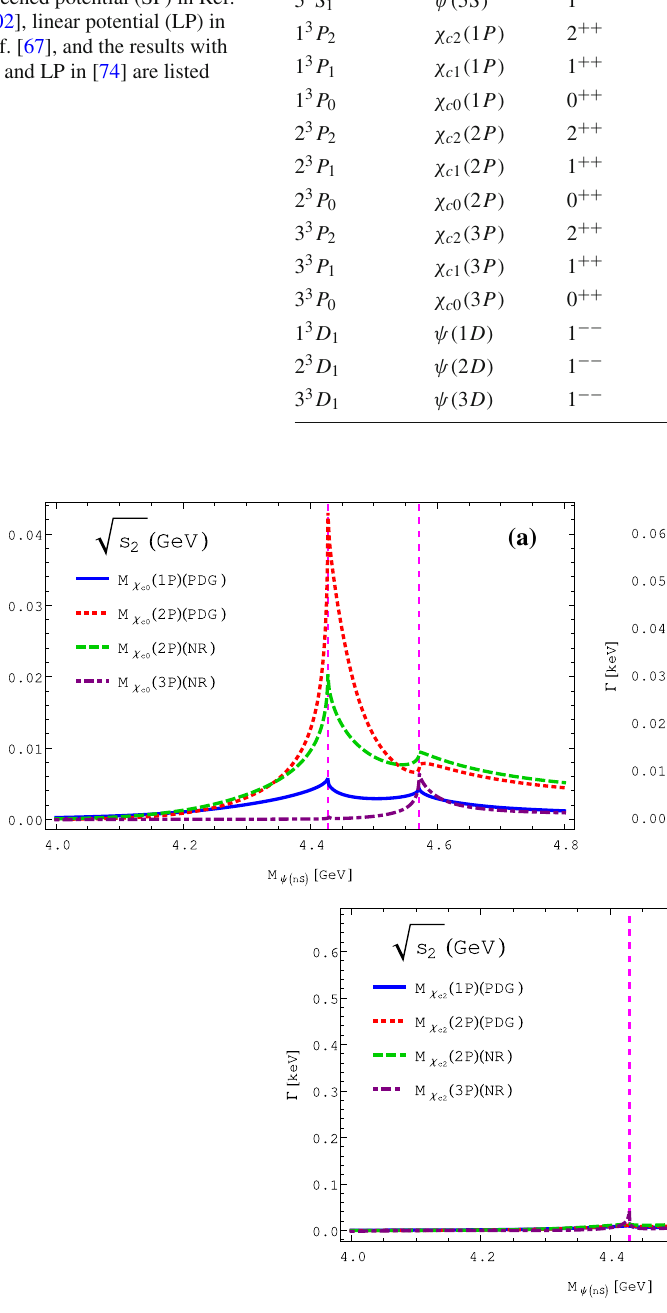
Table 2 The initial and final charmonium mass spectrum (in unit of GeV) used in this work. The measured masses from the PDG [4], the calculated with screened potential (SP) in Ref.